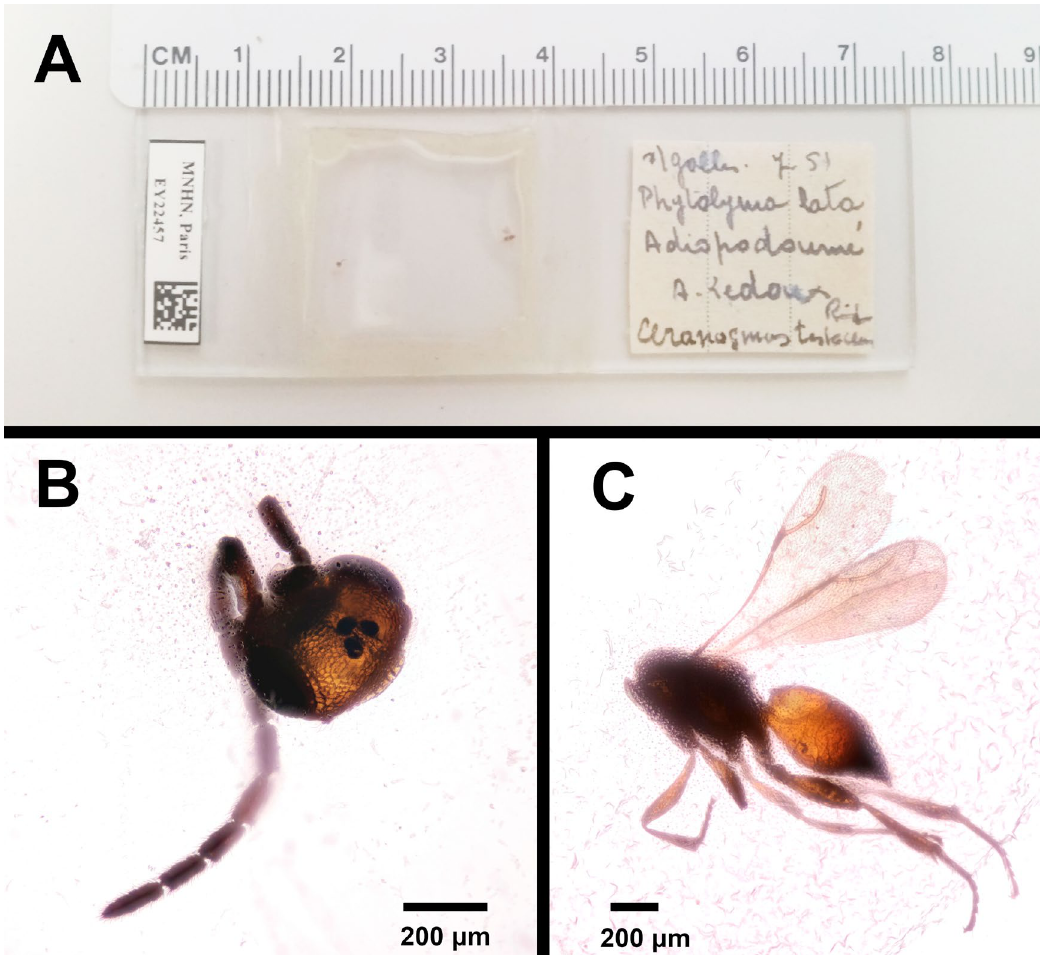
Fig. 27. The rediscovered male holotype of Ceraphron testaceus (risbec, 1953) (MNhN EY22457). A . The slide preparation, which consists of glycerine underneath a glass coverslip sealed with wax. B . A dorsal view of the head and antennae of the male specimen. C . A lateral habitus of the body, legs and wings. Imaging was difficult due to the state of the